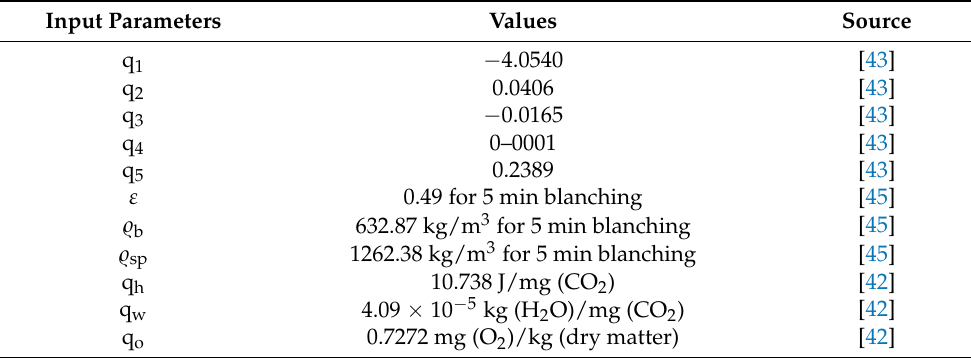
Table 1. Input parameters for the determination of gaseous